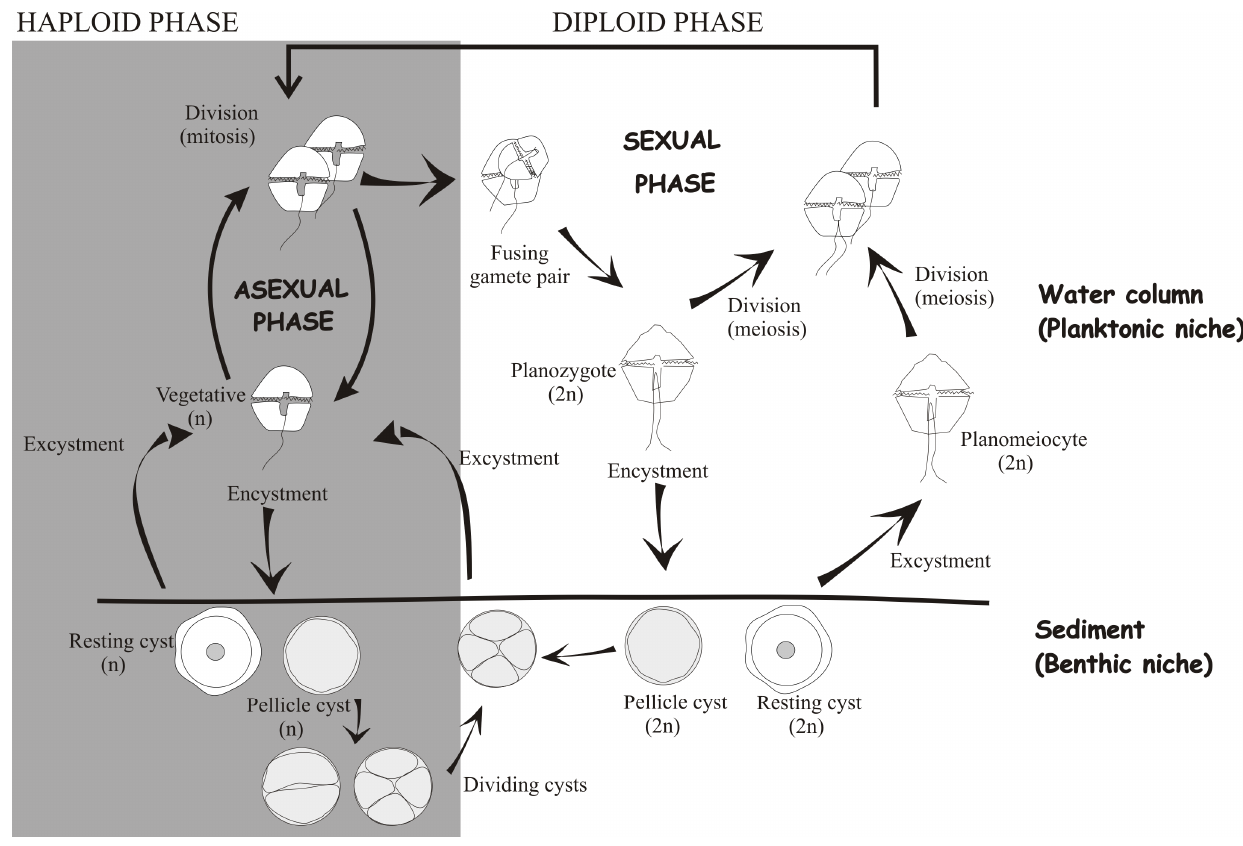
Figure 2. The life cycle of dinoflagellates, including all possible described